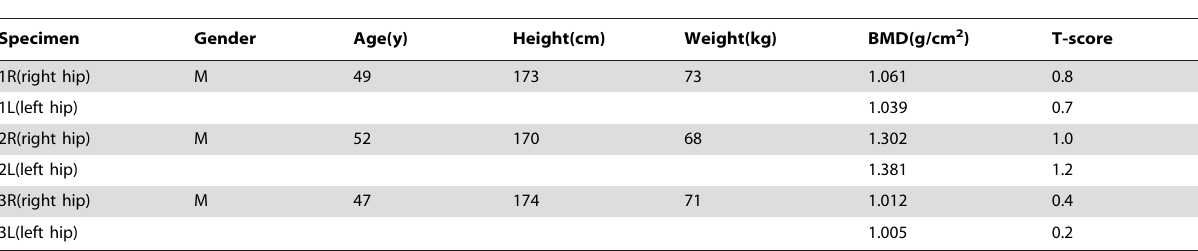
Table 1. Demographics of cadaver hip donors.